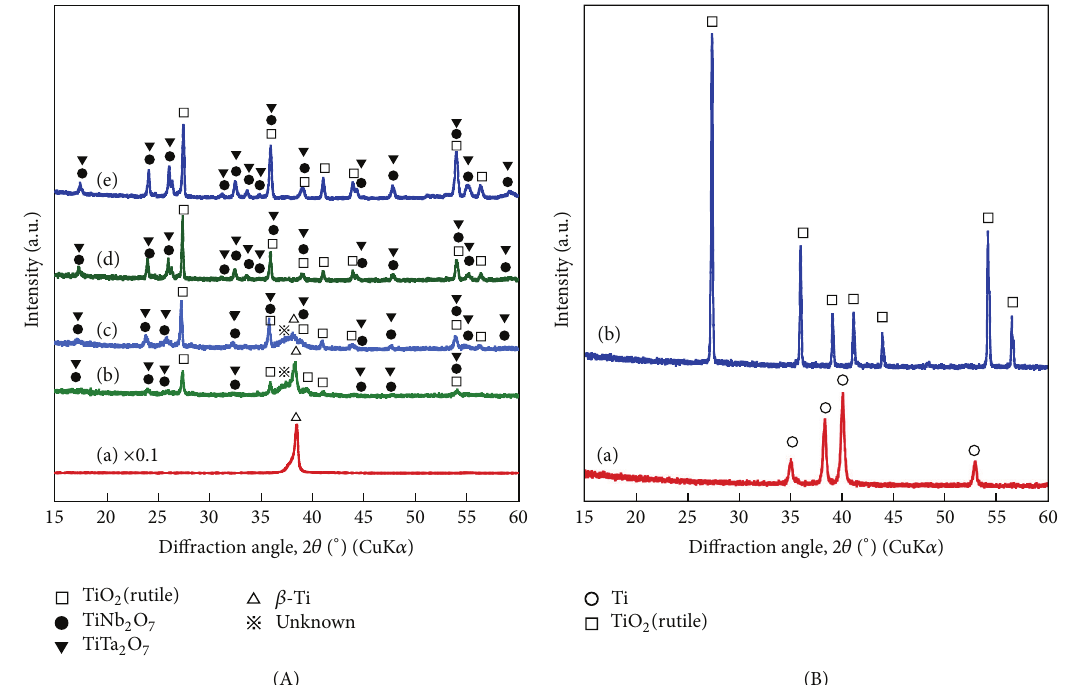
Figure 2: XRD patterns of (A) TNTZ and (B) CP Ti. (A-a) As-prepared, (A-b) heated at 900 ∘ C for 0.5 hr, (A-c) heated at 900 ∘ C for 1hr, (A-d) heated at 1000 ∘ C for 0.5 hr, (A-e) heated at 1000 ∘ C for 1hr, (B-a) as-prepared, and (B-b) heated at 1000 ∘ C for